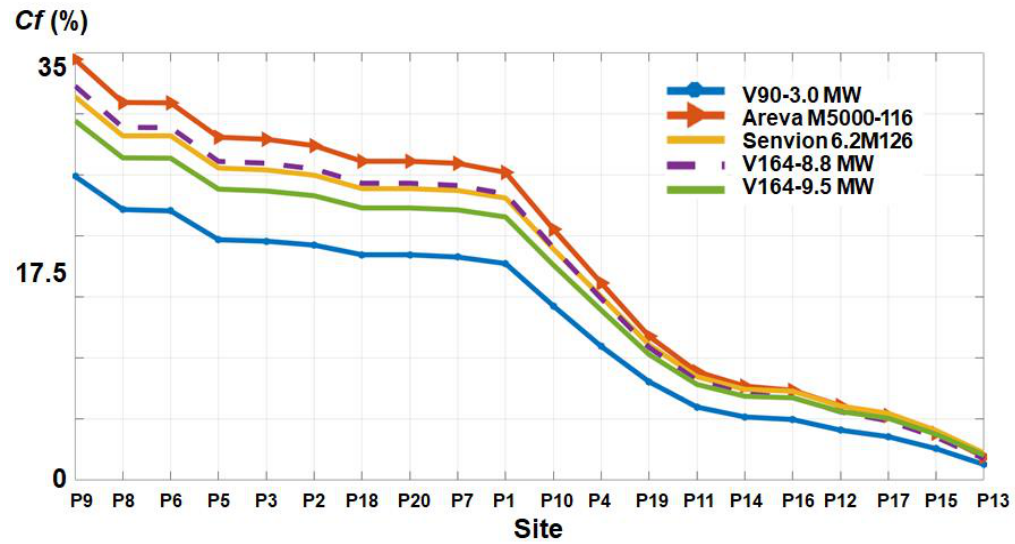
Figure 7. Capacity factor (in %) of the wind turbines considering the ERA-Interim data for the time interval January 1998–December 2017.